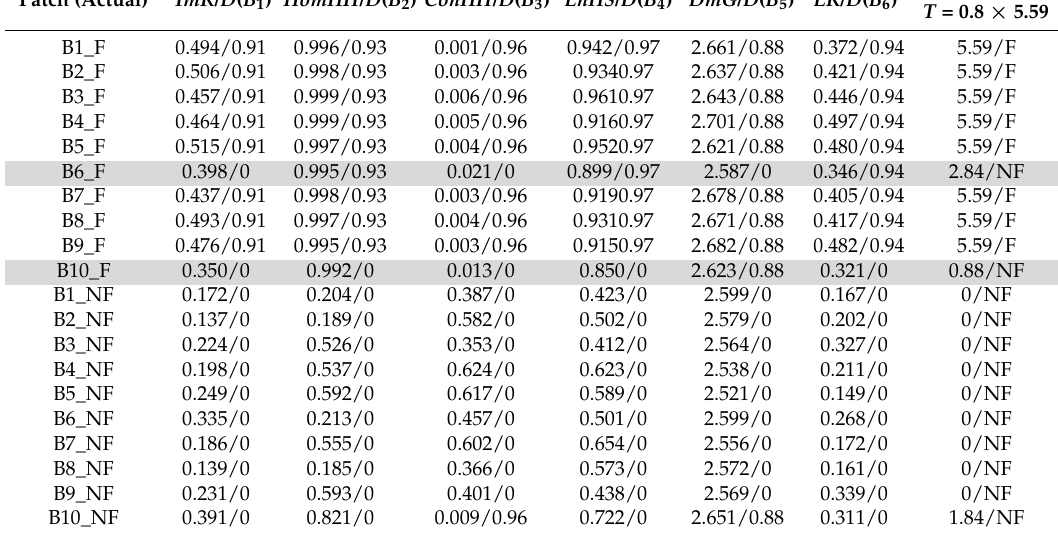
Table 6. Some experimental results concerning the patch classification based on voting scheme. Gray rows mean wrong classification.